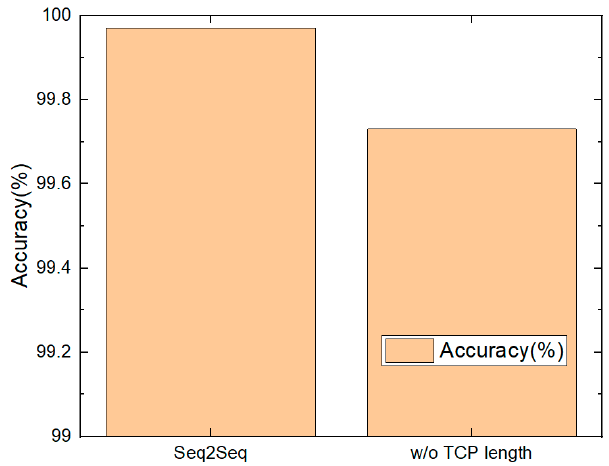
Table 6. Confusion matrix when the TCP length is not used.